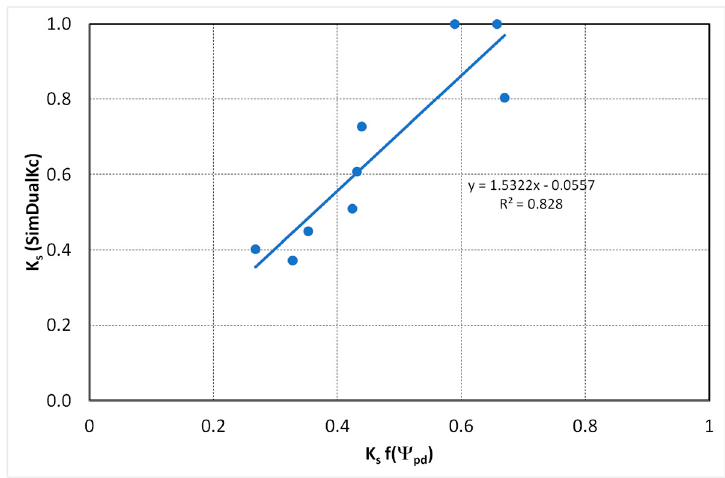
Figure 7. Relationship between K s derived from stress function obtained for Tempranillo variety and K s calculated by the SIMDualKc. Data from case study I (2017 and 2018). Atmosphere 2020 , 11 , x FOR PEER REVIEW 14 of 30